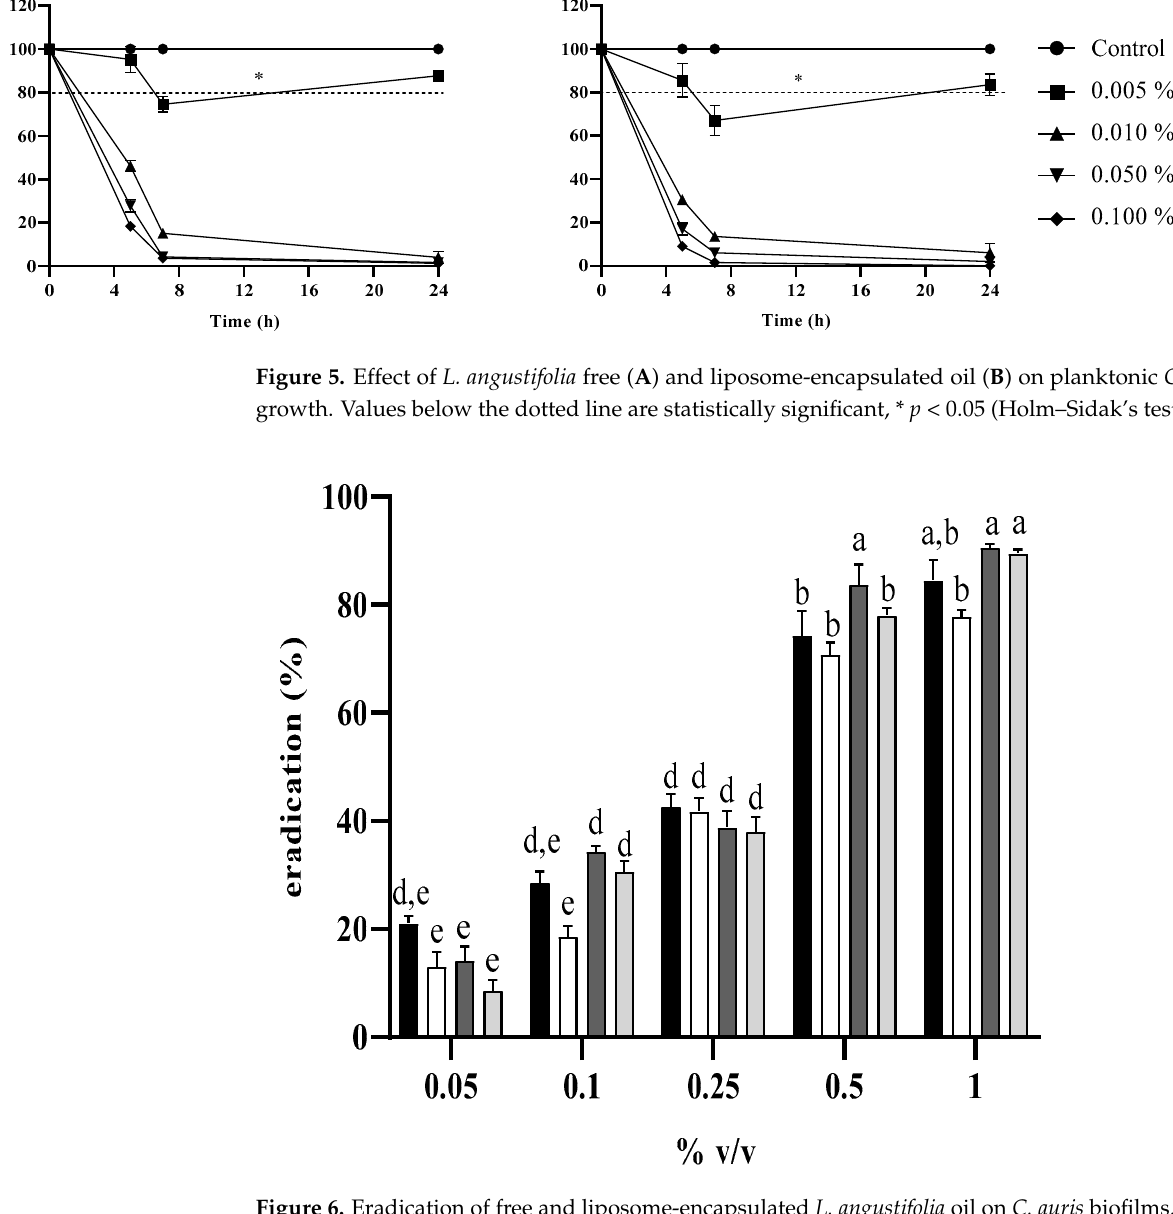
Figure 6. Eradication of free and liposome-encapsulated L. angustifolia oil on C. auris biofilms. Effect on primary biofilm: free oil (black bars); liposome-encapsulated oil (white bars). Effect on persister- derived biofilm: free oil (dark grey); liposome-encapsulate oil (light grey). Bars with different letters (a–e) are significantly different, bars with the same letters (a–e) are not significantly different (Tukay’s test, p < 0.05).